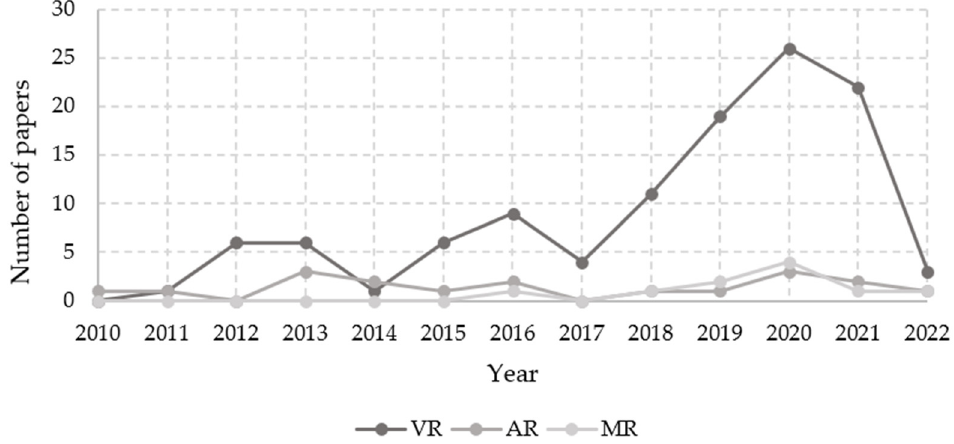
Figure 4. Number of articles in relation to the technology used by year of publication.